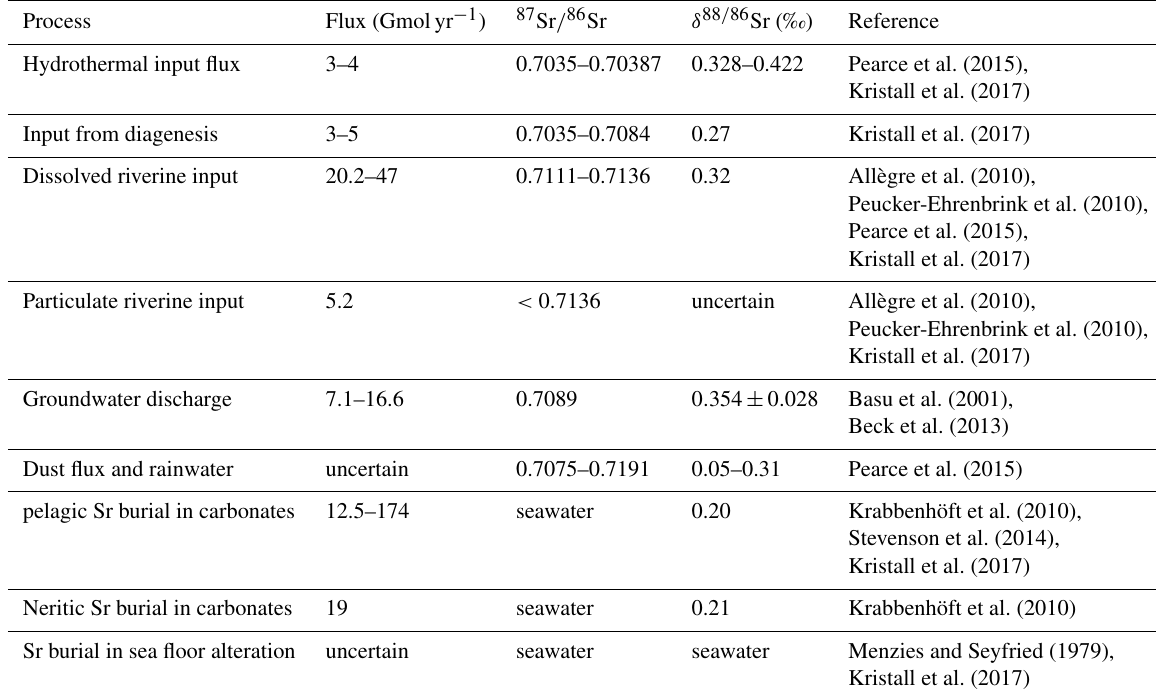
Table 1. Estimates of pre-industrial Sr fluxes between surface reservoirs and their isotopic composition.